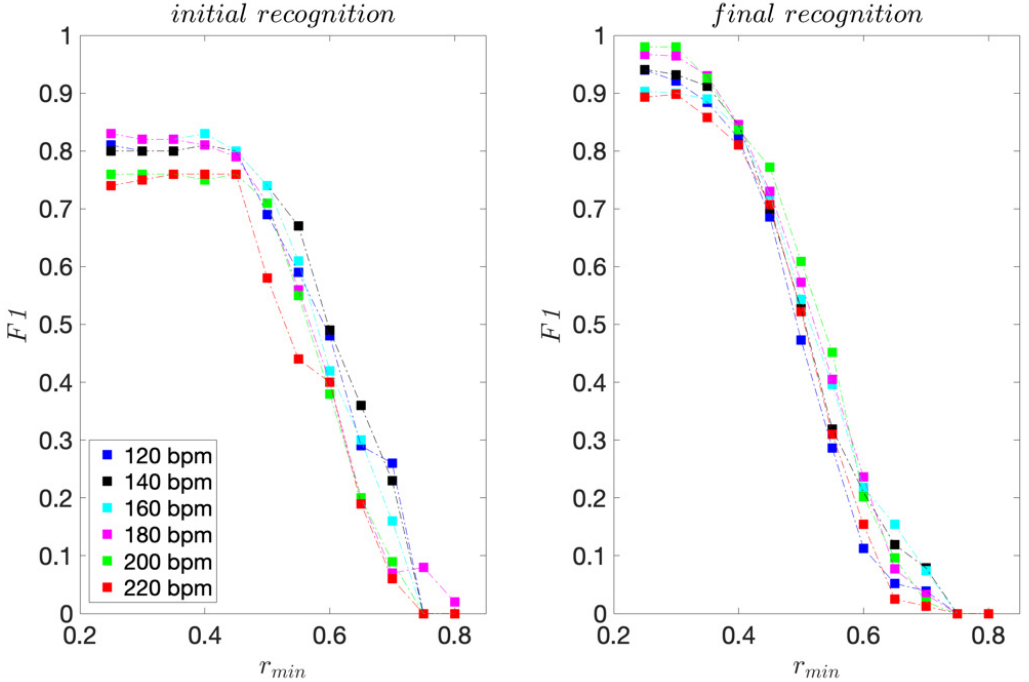
Figure 8. F1 scores obtained for the recreational dancers’ test